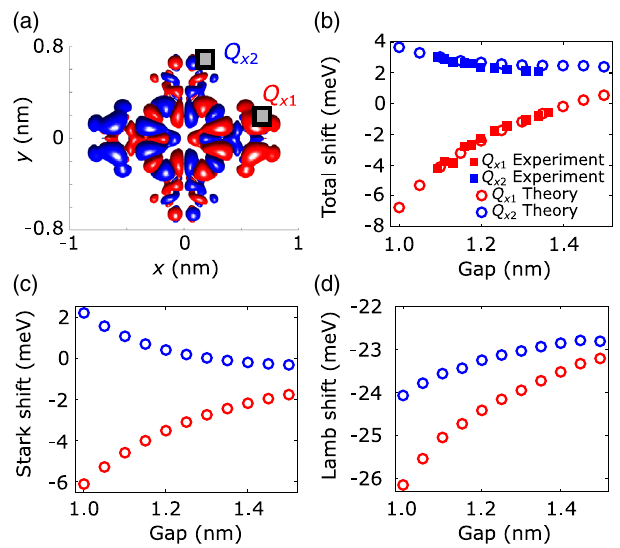
FIG. 9. Excitonic peak shift as a function of tip-substrate gap. (a) Transition charge density of Q with two squares marking the x positions of the tip used to calculate the Stark and the Lamb shift of excitons Q and Q . (b) Total peak shift calculated x 1 x 2 theoretically (circles) displayed together with the experimental data (squares) for Q (red) and Q (blue). For the theoretical x 1 x 2 data, the origin of the energy scale is offset and corresponds to FIG. 10. (a) STML spectra of a type-2 molecule recorded at a − 25 . 5 meV on the absolute scale. An energy of 1.815 eV fixed tip-sample distance for bias voltages varying from − 2 . 3 V corresponding to the energy of the unperturbed exciton on the (bottom curve) to − 3 V (top curve) in 0.1 V increments. Inset: substrate has been subtracted from the experimental data. The STM image of the H 2 Pc molecule. The measurement position is numerically calculated contributions to the total shift emerging marked by a dot; V ¼ − 2 . 5 V, I ¼ 5 pA, and the scale bar is from the Stark shift and from the Lamb shift are shown in panels 1 nm. (b) Constant-height scanning tunneling spectroscopy of the (c) and (d), respectively. H 2 Pc molecule recorded at a position marked in panel